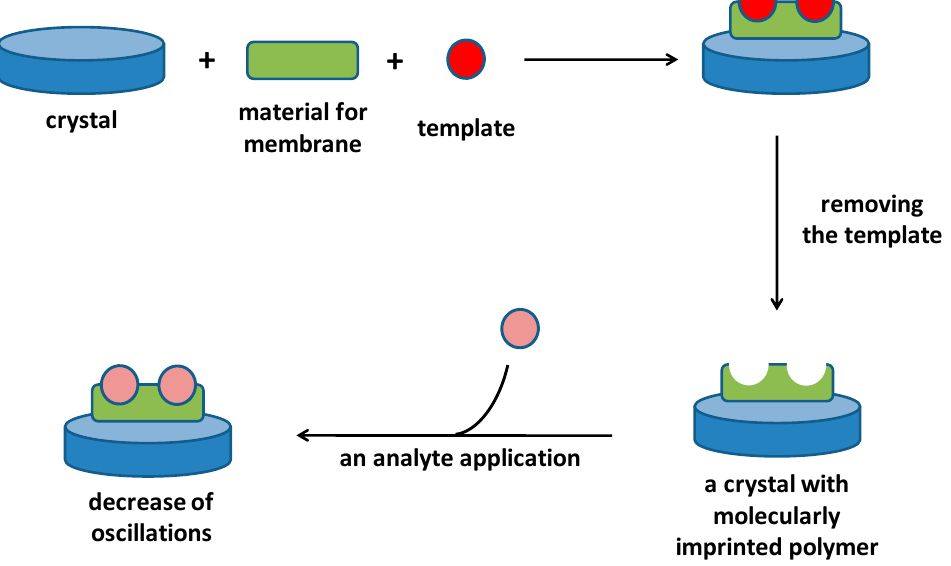
Figure 4. Covering of crystal with a Molecularly Imprinted Polymer and following assay of an analyte chemically identical or close to the template.